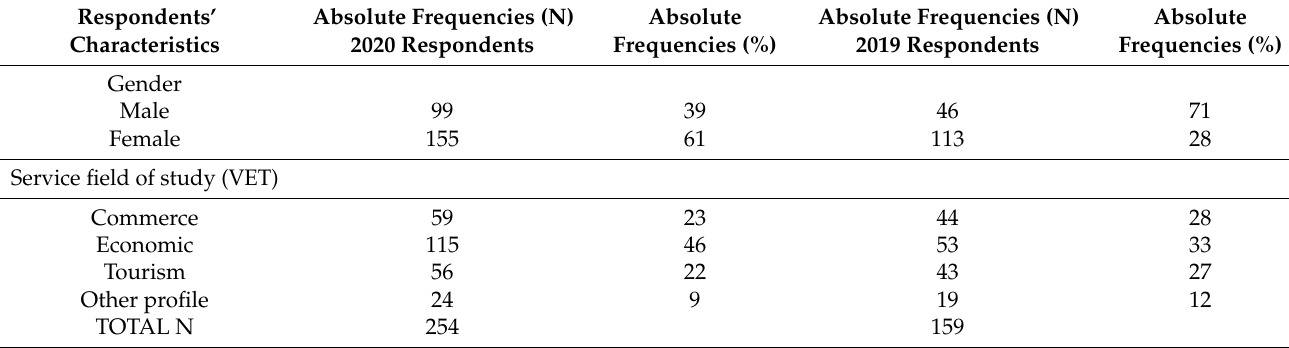
Table 2. The number of responses corresponding to the high school service profiles in the Questionnaires.